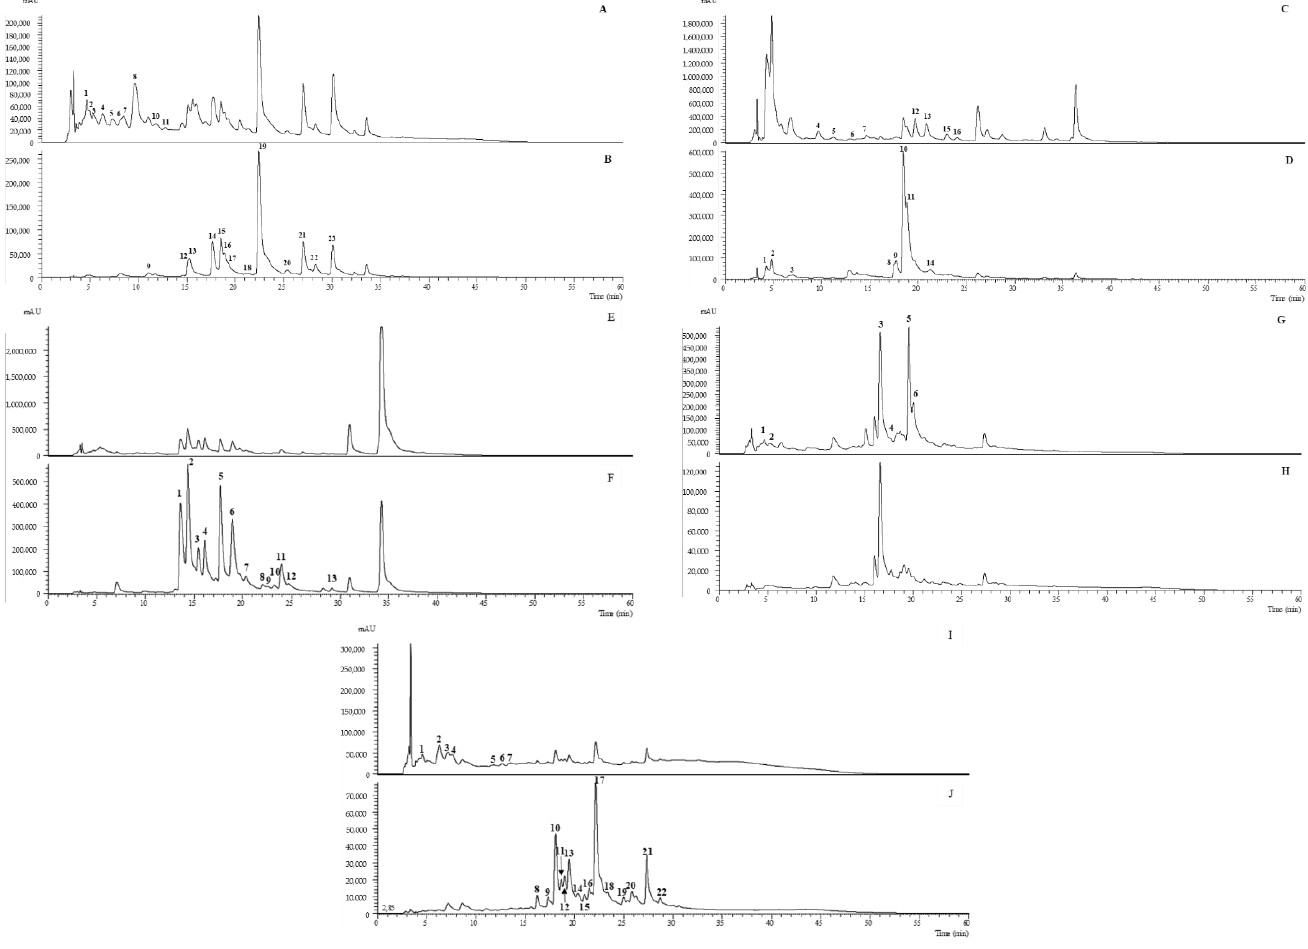
Figure 1. Illustrative phenolic profiles of C. vulgaris ( A and B ), G. tridentata ( C and D ), C. multiflorus ( E and F ), V. sinuatum ( G and H ), and C. edulis ( I and J ), recorded at 280 and 370 nm,